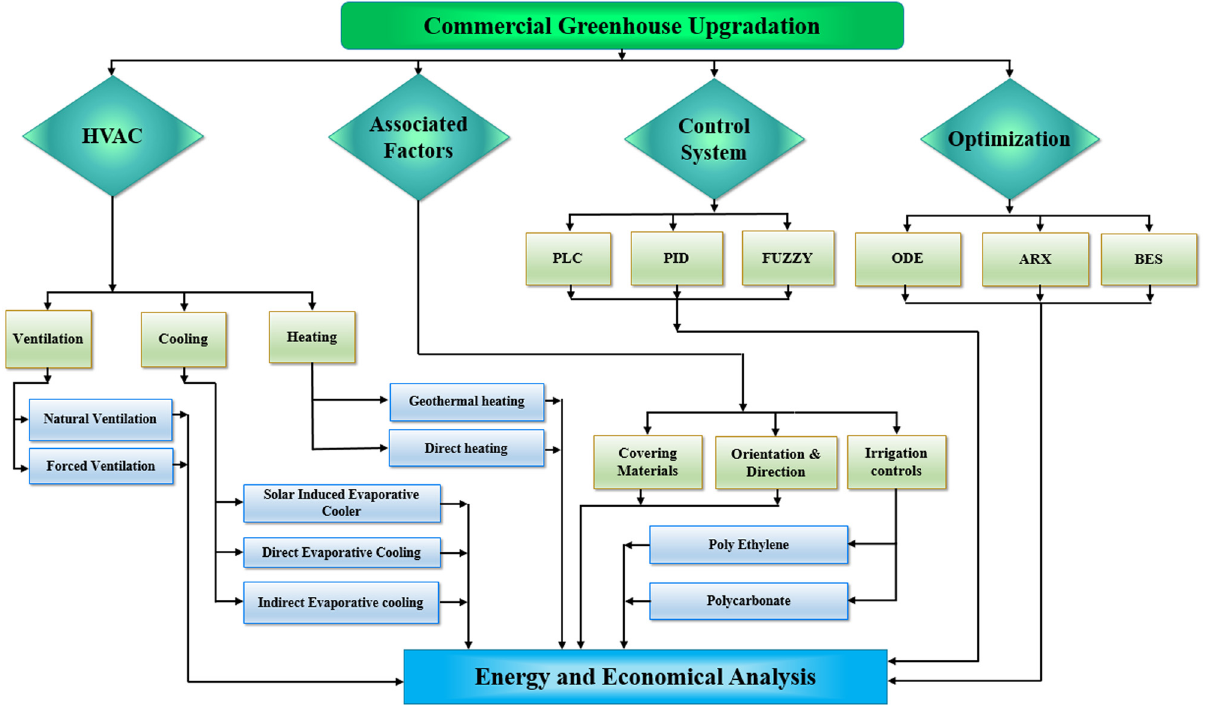
Figure 1: Flow chart of the commercial greenhouse upgradation